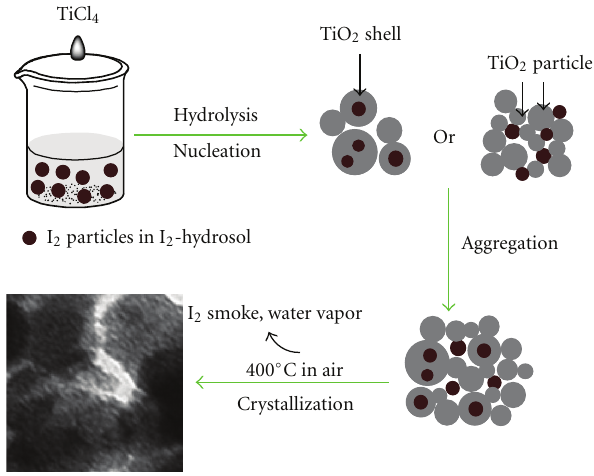
Figure 4: Proposed formation mechanism of (I 2 ) n sensitized nanoporous TiO 2 .